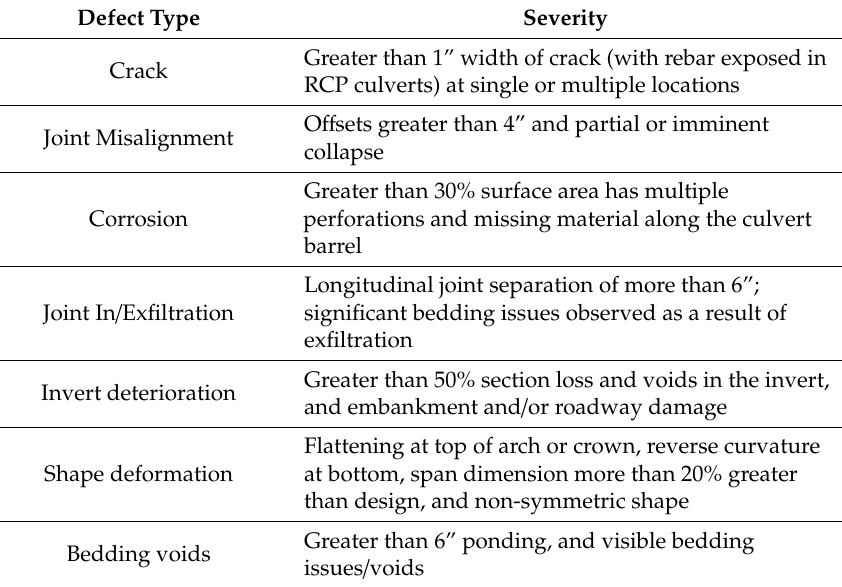
Table 5. Threshold defect